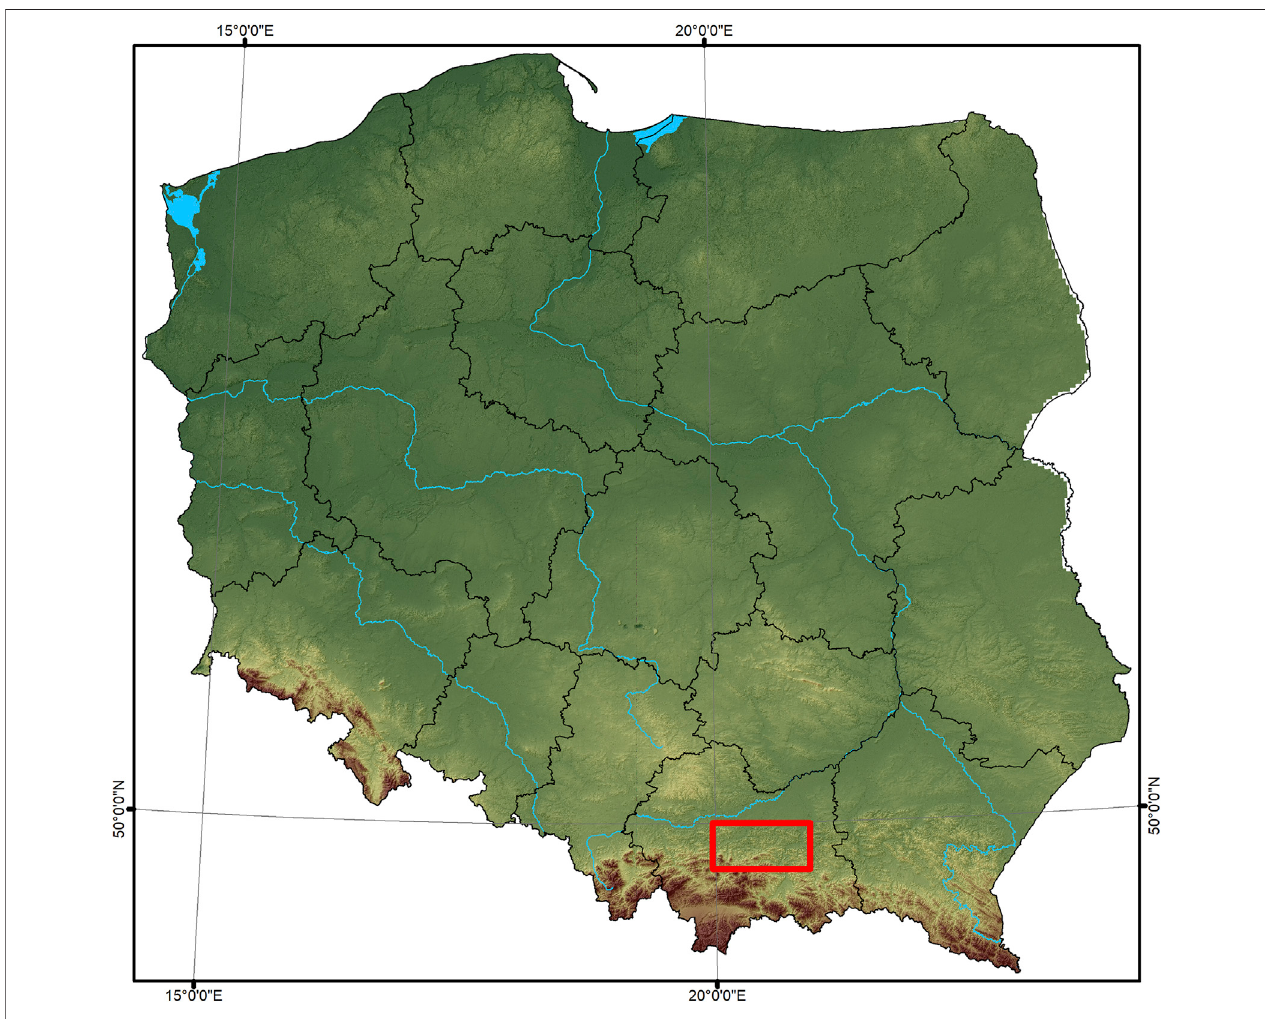
FIGURE 1 | Location on the study